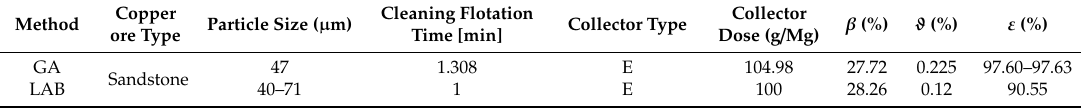
Table 14. The results obtained during the analysis of all cases in the Denver flotation machine. Method